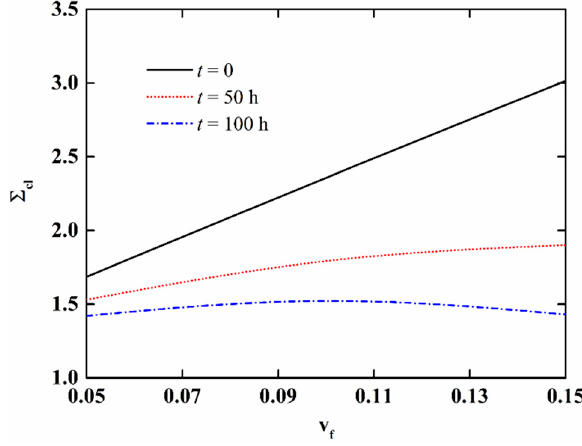
Figure 10. Variation in the critical load of imperfect NFRC cylindrical shells with fiber content.